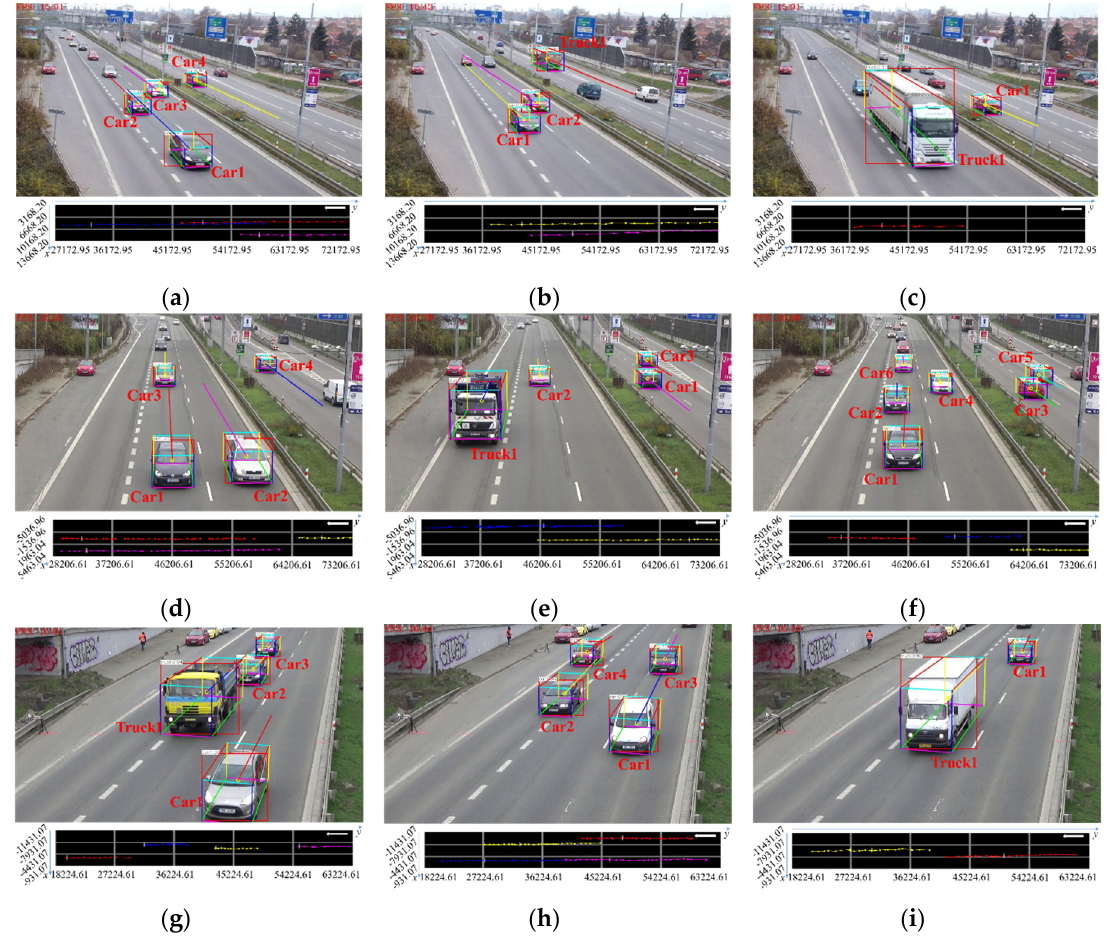
Figure 12. Examples of vehicle spatial distribution and 3D trajectory extraction in dataset road scene.